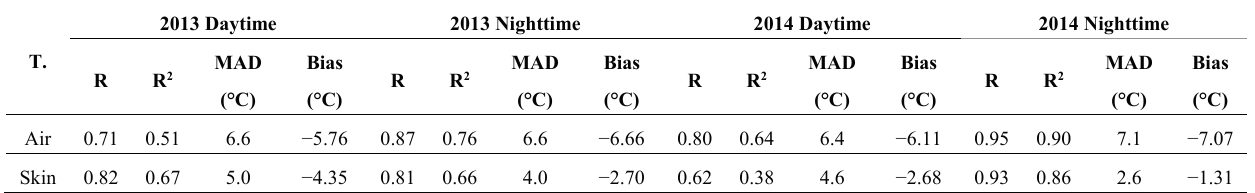
Table 2 . R 2 correlation coefficient values between VIIRS LST, T-skin, and T-air at CREST-SAFE for winters 2013 and 2014 daytime and nighttime